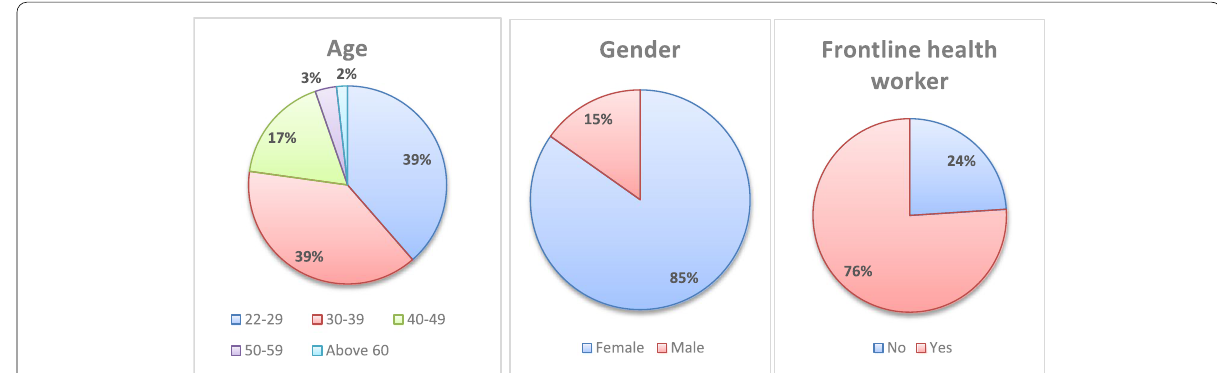
Fig. 1 Sociodemographic data of participating dental teaching staff of the Faculty of Dentistry, Ain Shams University ( N